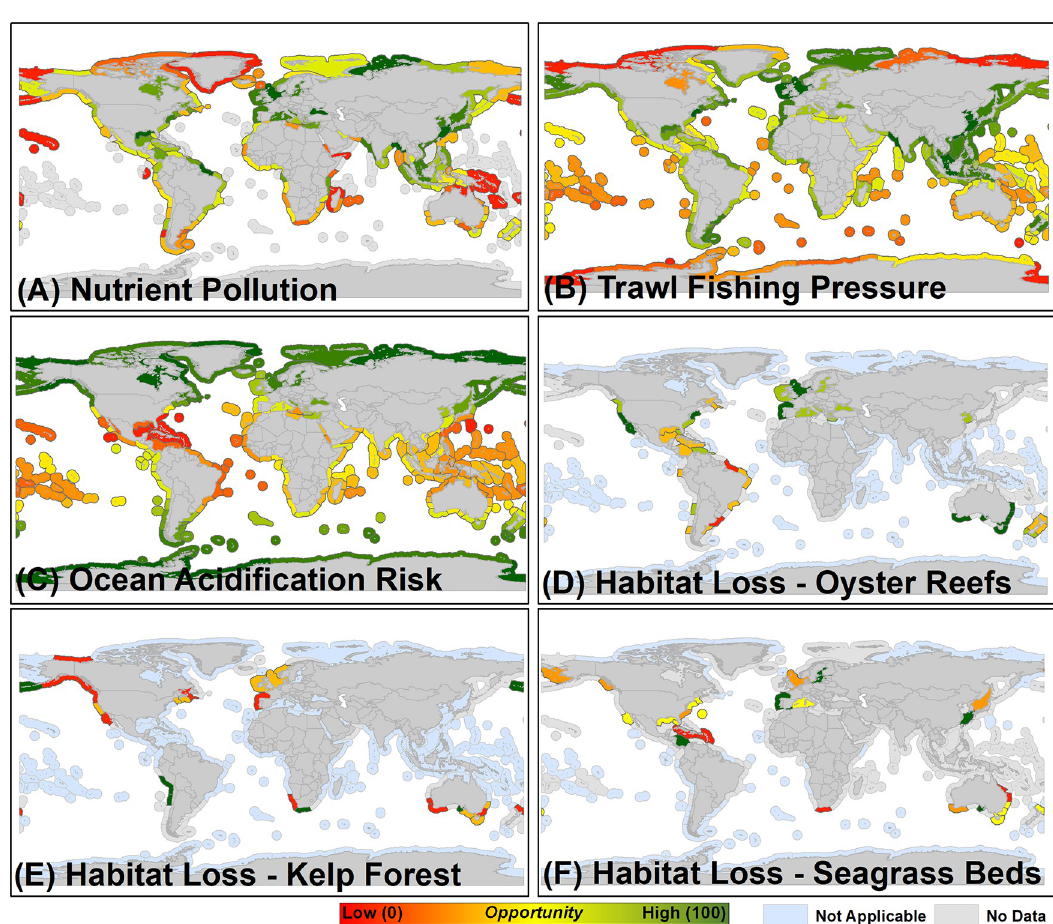
Fig 1. Environmental factors integrated within the restorative aquaculture opportunity index used in determining high opportunity marine ecoregions for shellfish and seaweed restorative aquaculture development, including (A) nutrient pollution, (B) trawl fishing pressure, (C) ocean acidification risk, (D) oyster reef habitat loss, (E) kelp forest habitat loss, and (F) seagrass bed habitat loss. All factors are re-scaled to represent where shellfish and seaweed aquaculture development would provide maximum benefits (see Table 1). For example, marine ecoregions with the greatest oyster reef habitat loss (B) are re-scaled to represent the highest opportunity ecoregions (dark green) where shellfish and seaweed aquaculture could provide habitat enhancement